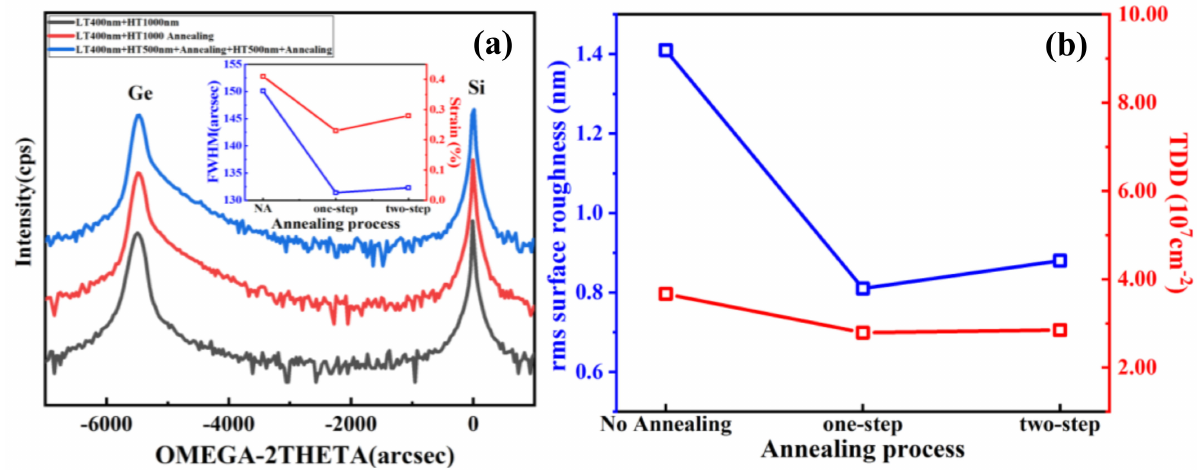
Figure 13. ( a ) HRXRD (004) rocking curves of (LT + HT) Ge grown on Si substrate with different annealing processes: no annealing, one-step annealing, two-step annealing, the inset shows the FWHM left and calculated strain of each sample. The RMS values and the TDD calculated by HRXRD are displayed in ( b